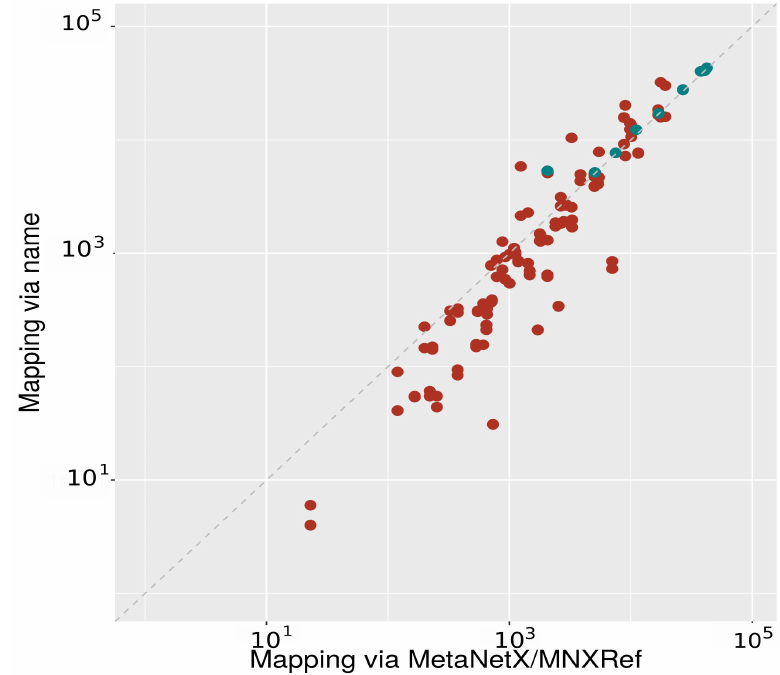
Figure 3. Number of mappings using the two approaches: The x axis shows the mappings resulted using MNXRef ID as a bridge; the y axis shows the number of mappings via name. Each red dot indicates a mapping between a pair of databases, points in blue indicate mappings from a database to itself. Mapping results from/to SLM are not shown in the plot due to the high number of matches outside the considered